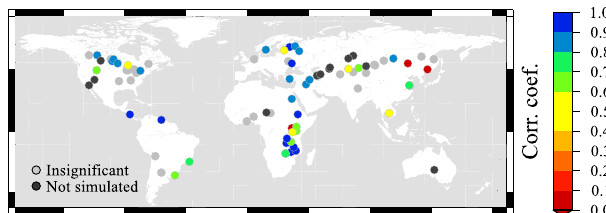
Fig. 11. Map of correlation coefficients in lake level climatologies between the MPI-HM simulation and GRLM observation. Light grey points indicate insignificant correlations and dark grey points indicate locations where no surface water body was simulated by the